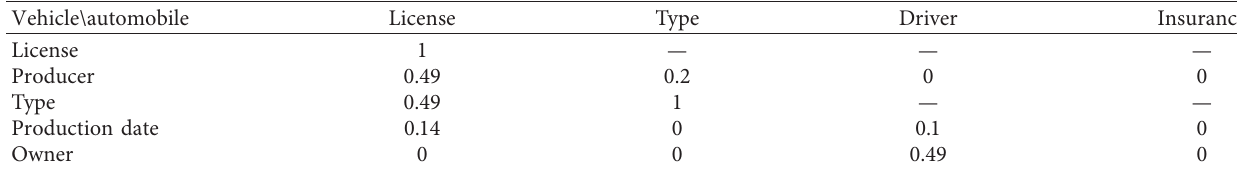
Table 6: Matching between attributes, Set 1.